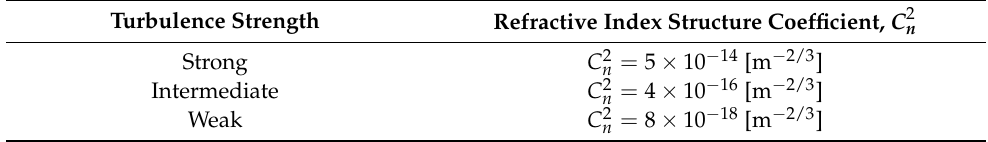
Table 8. Typical refractive index structure coefficient values for turbulence adapted from [47]. Turbulence